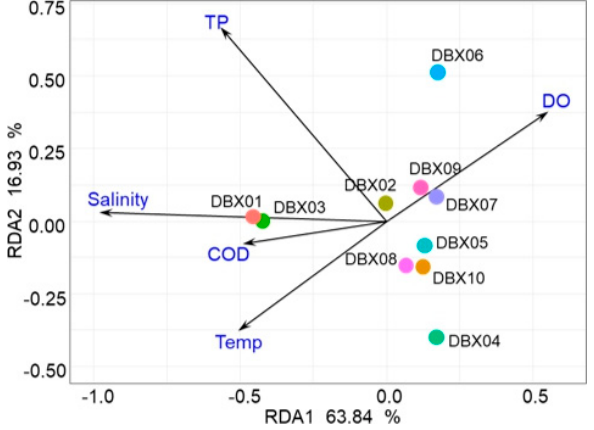
Figure 4. Redundancy component analysis of the eukaryotic phytoplankton community and environmental factors.